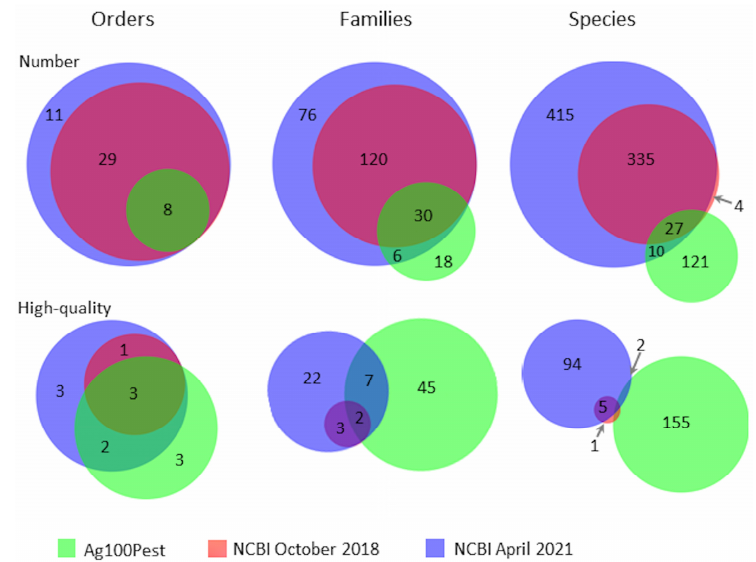
Figure 2. Venn diagrams showing the number of species present in NCBI for the phylum Arthropoda at the initiation of the Ag100Pest Initiative and at present compared to the species included in the Ag100Pest Initiative. NCBI data was accessed on 24 October 2018 and 27 April 2021, respectively. The top row includes all species present in NCBI, and the bottom row includes only those species with an assembly deemed high-quality at the taxonomic levels of order, family, and species. Assemblies with a contig N50 of 1 Mbp or greater and scaffolding with an N50 of 10 Mbp or greater were deemed high-quality. Assemblies without clear scaffolding (scaffold N50 > contig N50) were not evaluated as high-quality. We strive to produce high-quality genome assemblies for all species covered by the Ag100Pest